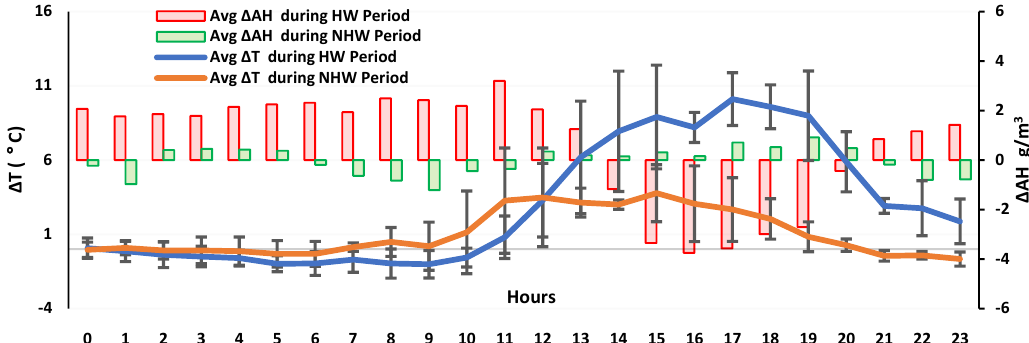
Figure 2. Mean urban overheating intensity (ΔT = Penrith Lakes − OBS Hill) and AH difference (ΔAH = Penrith Lakes − OBS Hill) during HW (9–11 February 2017) & NHW (13–15 February 2017) periods. The whiskers represent the standard deviation.